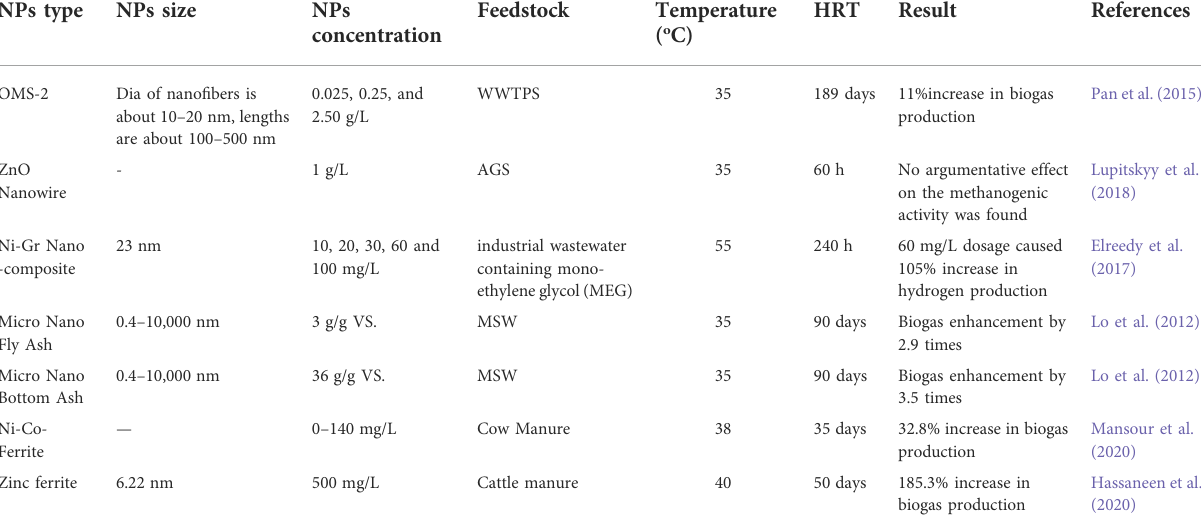
TABLE 7 The reported nanowire, nano-composite, nano-ash, and their in fl uence on biogas